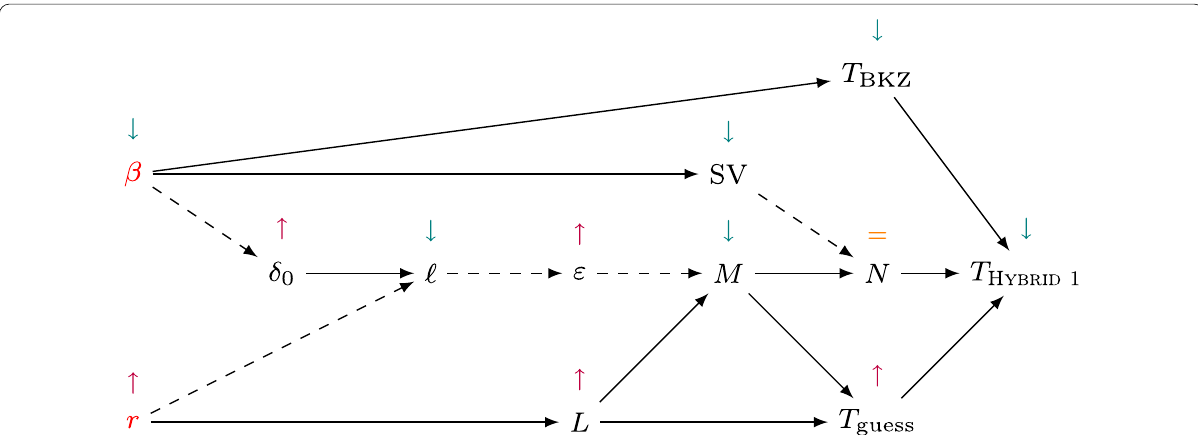
Fig. 1 Parameter relations and their value changes from dual attack to H ybrid 1 . An arrow “ increasing A will increase (respectively, decrease) B . “ increased and β is decreased while maintaining M